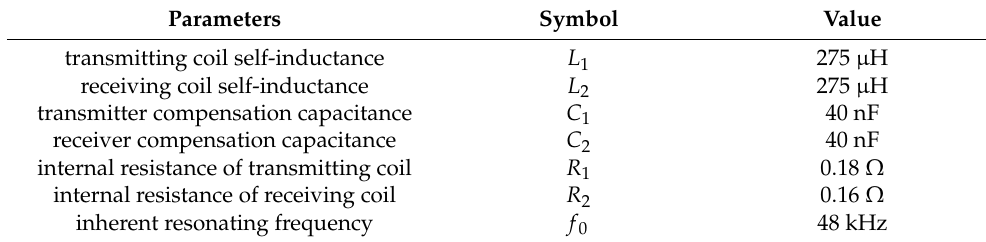
Figure 12. WPT system experimental platform. Table 1. Main parameters of WPT system.